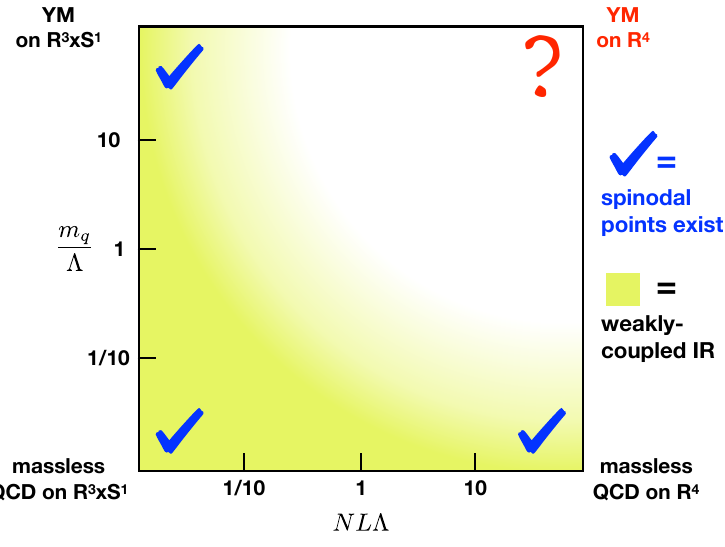
Figure 6 . [Color Online.] A cartoon mapping out the regions in gauge-theory parameter space where spinodal points exist. We consider QCD on R 3 (cid:2) S 1 with boundary conditions that preserve a Z N color-(cid:13)avor-center (CFC) symmetry [73], and vary the quark mass m q and the circle size L , assuming that CFC symmetry is preserved at small L . When m q (cid:29) (cid:3) the CFC symmetry reduces to the usual center symmetry. In all regions where the physics can be quantitatively explored (shaded yellow), there are spinodal points which appear as a function of (cid:18)